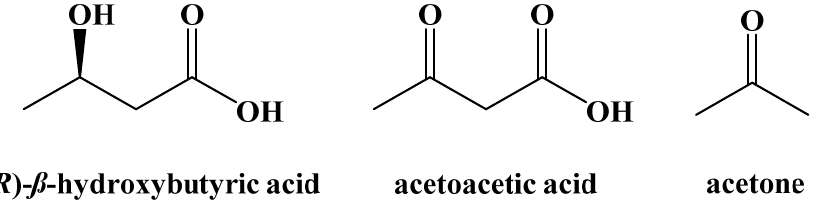
Figure 1. The Ketone